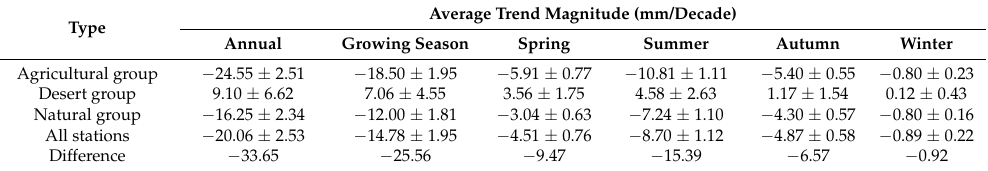
Table 3. ET0 trend magnitudes of different station groups, 1960–2013.